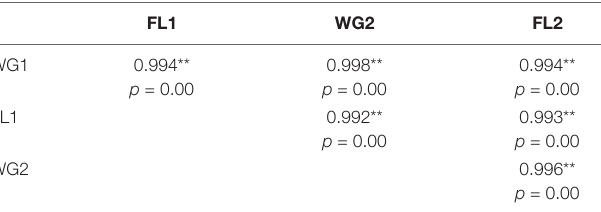
TABLE 3 | Two-tailed Pearson correlation analysis in flour and whole-grain digested with traditional and modified digestion